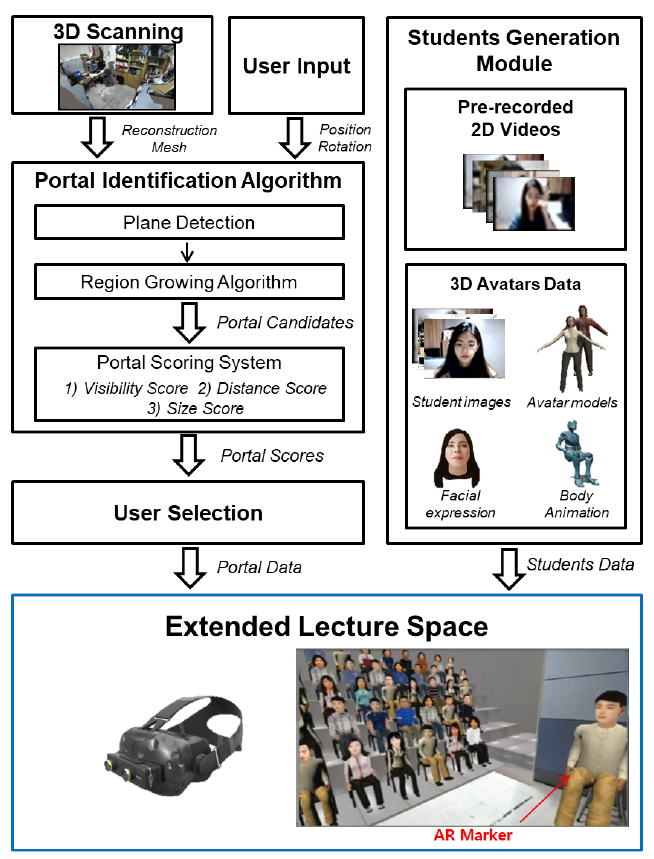
Figure 4. The overall system configuration of